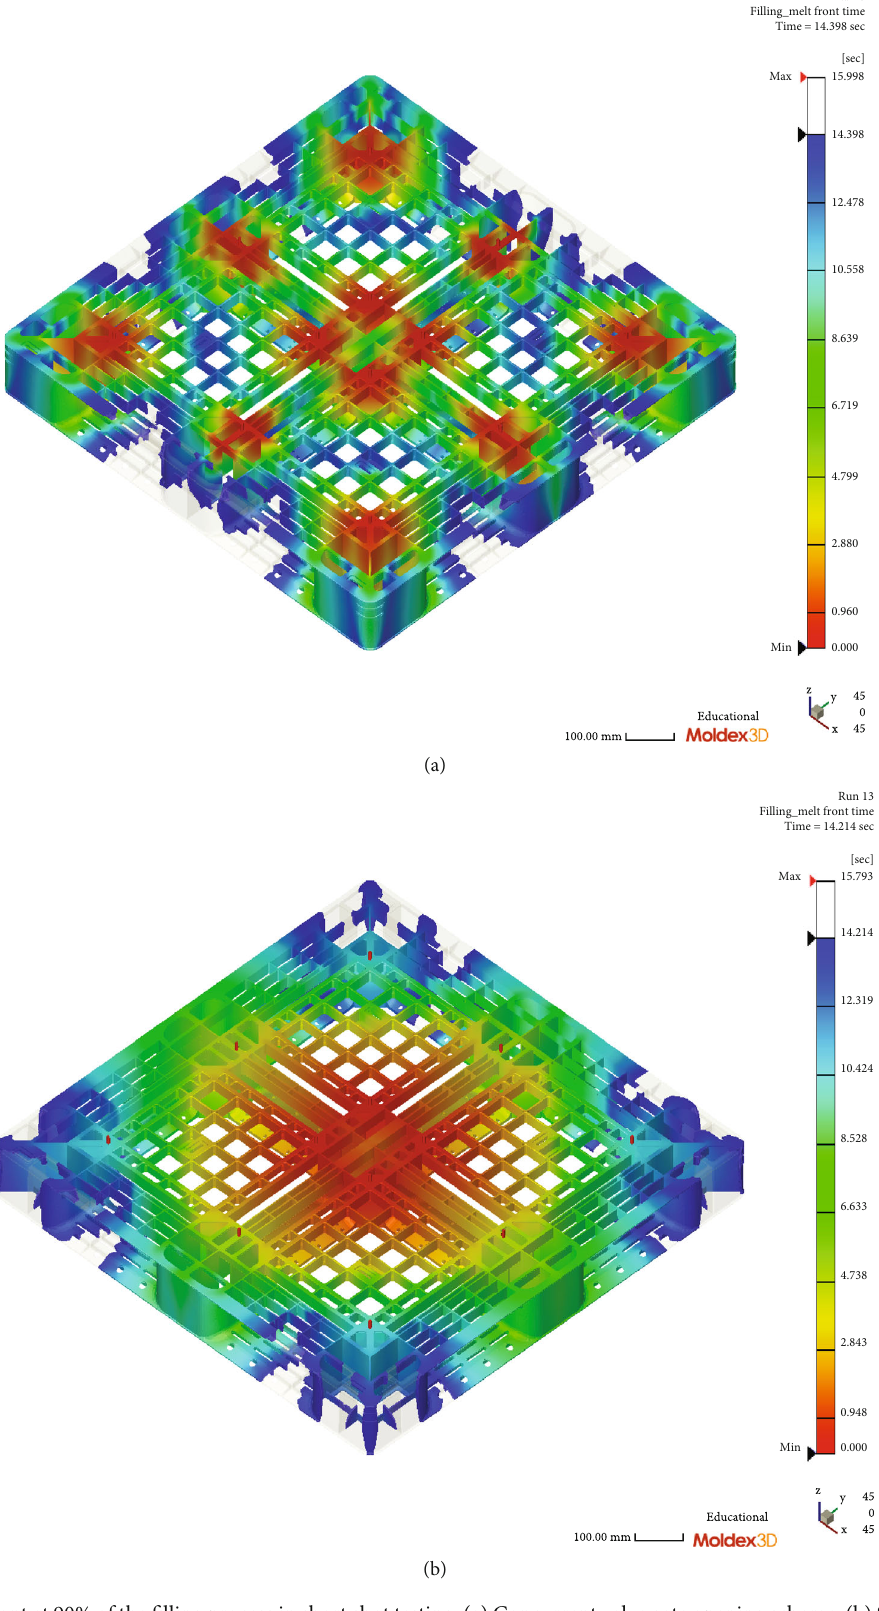
Figure 5: The fl ow front at 90% of the fi lling process in short shot testing. (a) Concurrent valve gate opening scheme. (b) Sequential valve gate opening